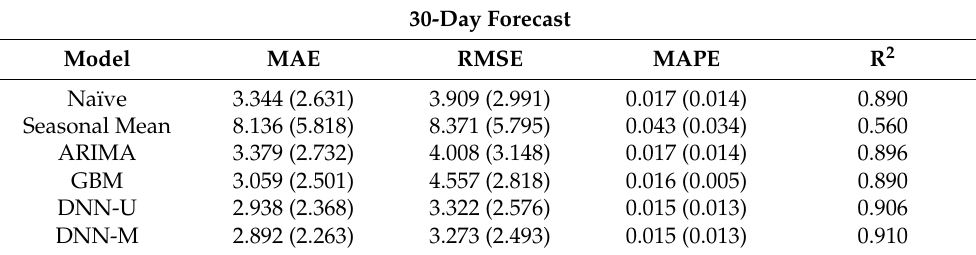
Table 6. Estimates for MAE, RMSE, MAPE, and R 2 calculated using TSCV for a 30-day forecast.